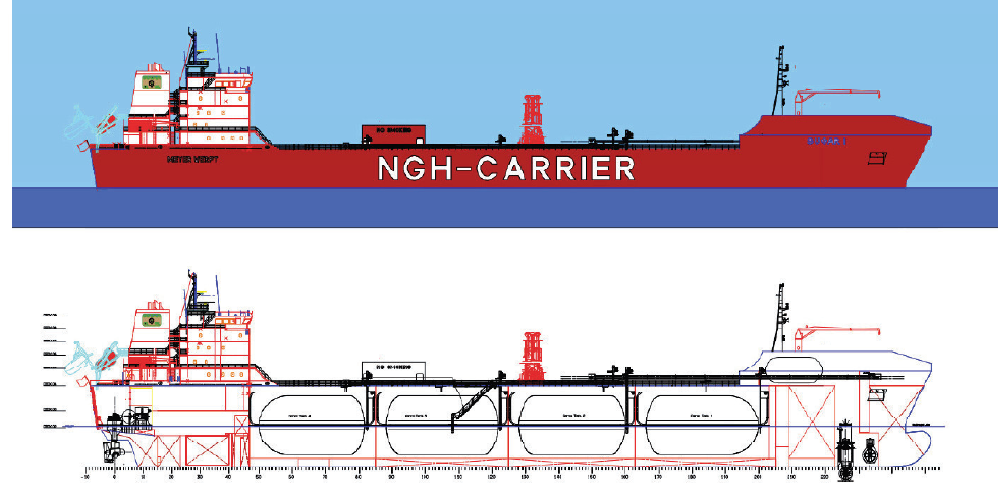
Figure 5. Design drawing of the pellet